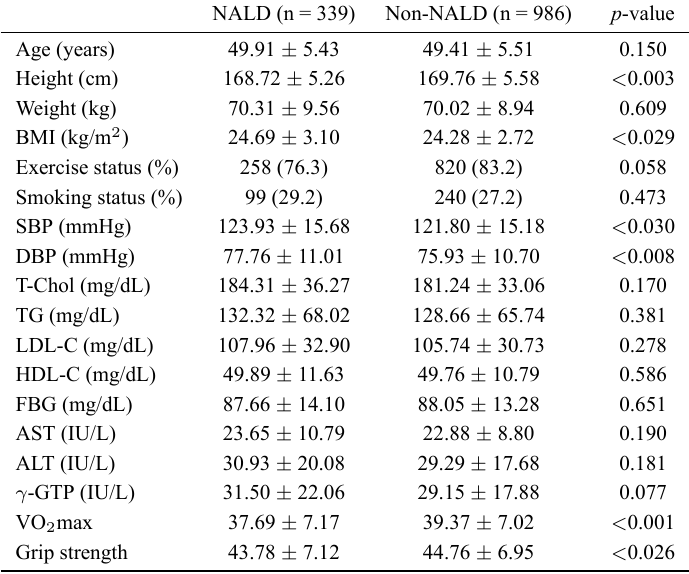
Table 1. Clinical characteristics in NAFLD and